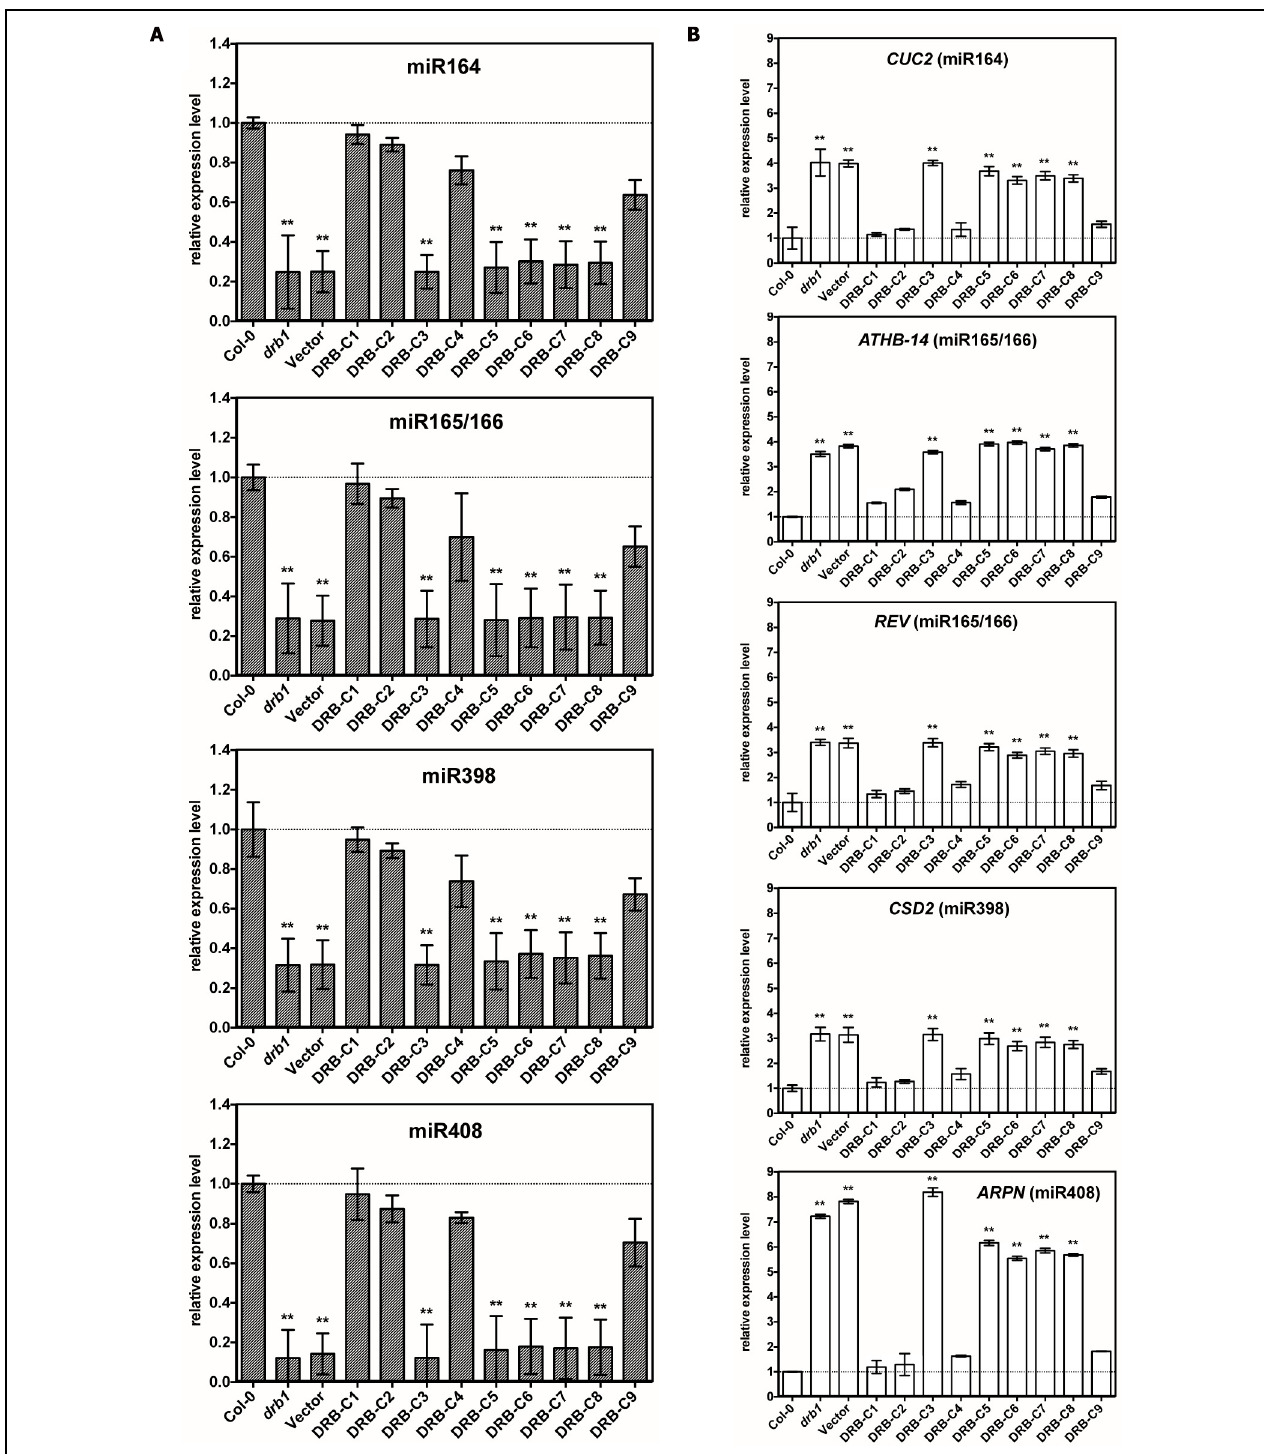
FIGURE 3 | miRNA accumulation and their target levels in wild-type, drb1 , and transgenic plants. (A) Stem-loop RT-PCR quantification of miRNA accumulation relative to Col-0 wild-type levels (dashed line) ( n = 3, ± SD, ∗∗ p -value < 0.01). miRNA levels are normalized to SnoR101 accumulation. (B) RT-PCR quantification of miRNA target gene expression relative to Col-0 wild-type levels (dashed line) ( n = 3, ± SD, ∗∗ p -value < 0.01). Gene expression levels normalized to ACTIN2 (AT3G18780) expression.